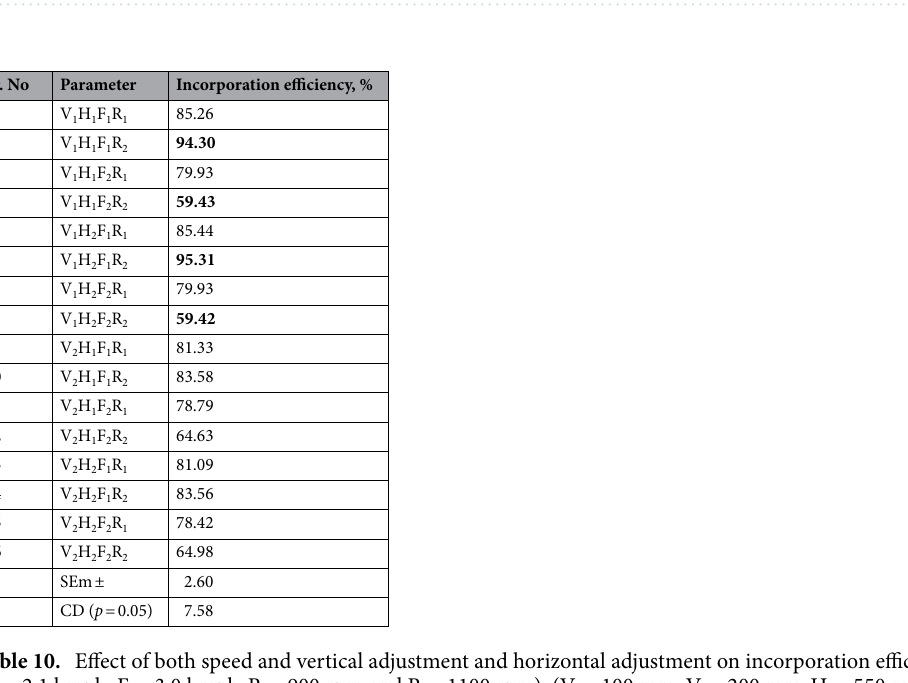
Table 9. The field test included fuel consumption, efficiency, and actual and theoretical field capacity.